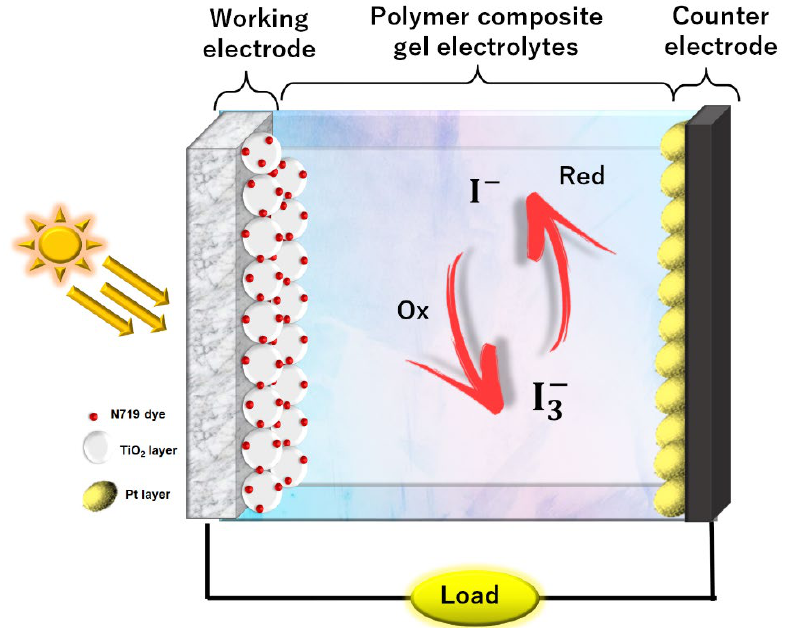
Figure 1. Illustration of DSSC using the configuration of FTO substrate/TiO 2 /N719 ruthenium dye/PCGE/Pt/FTO substrate.